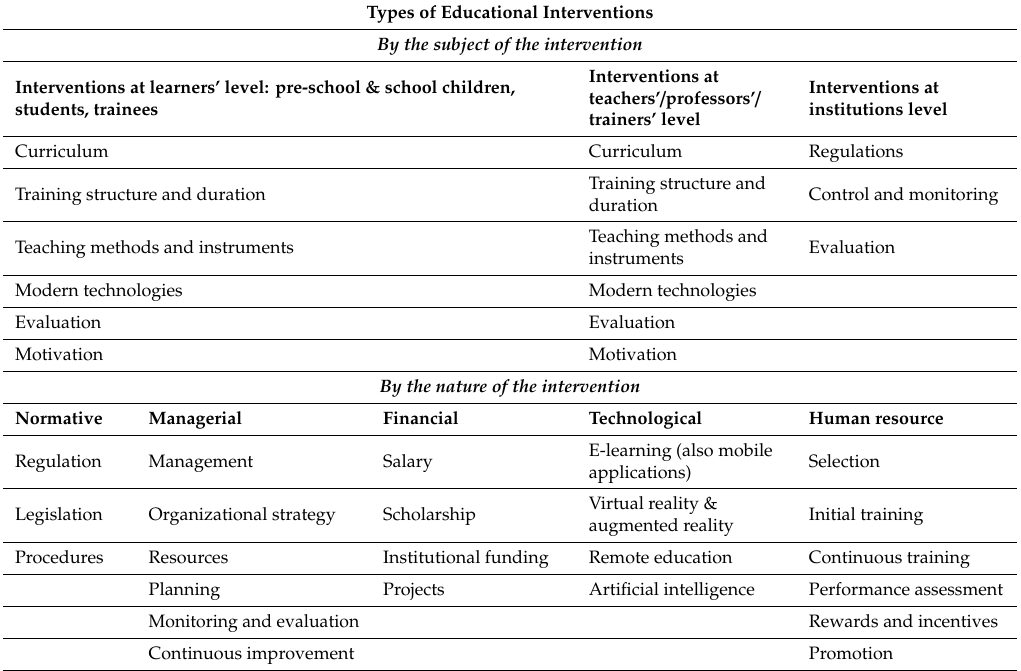
Table 4. Classification of educational